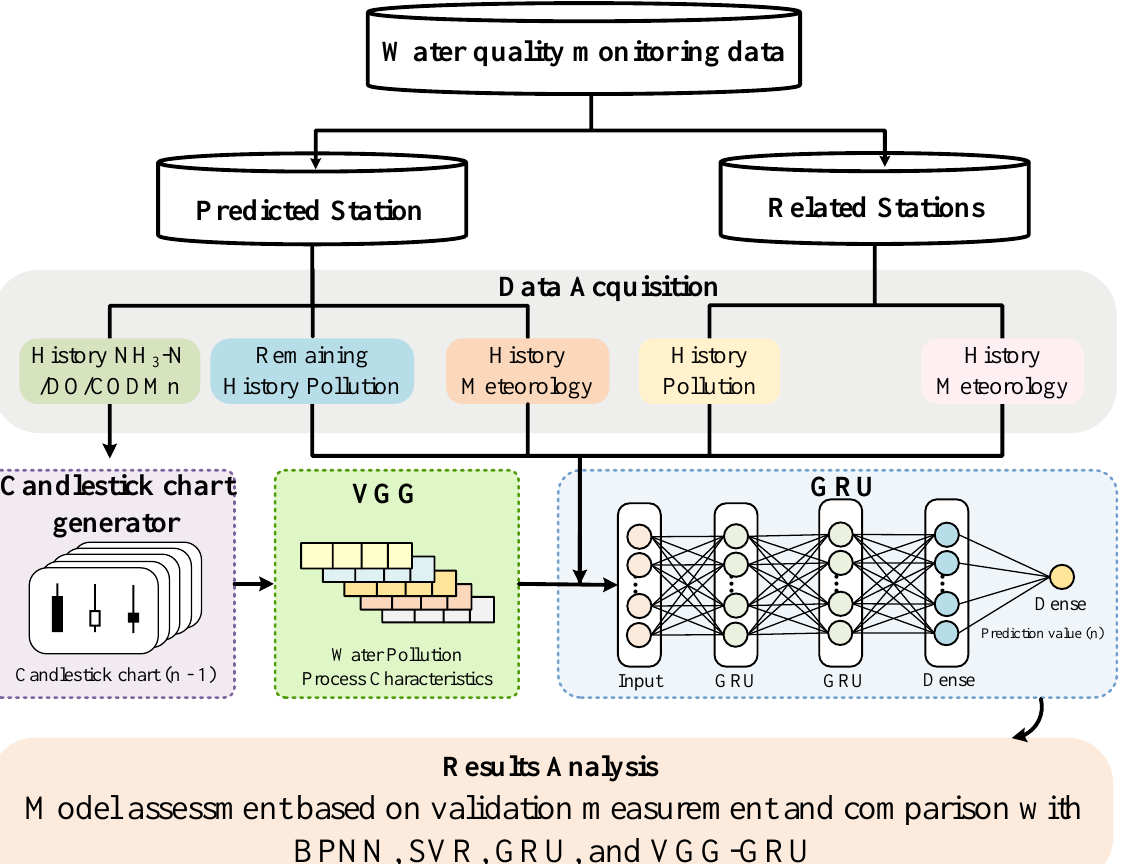
Figure 2. Framework of the proposed model.